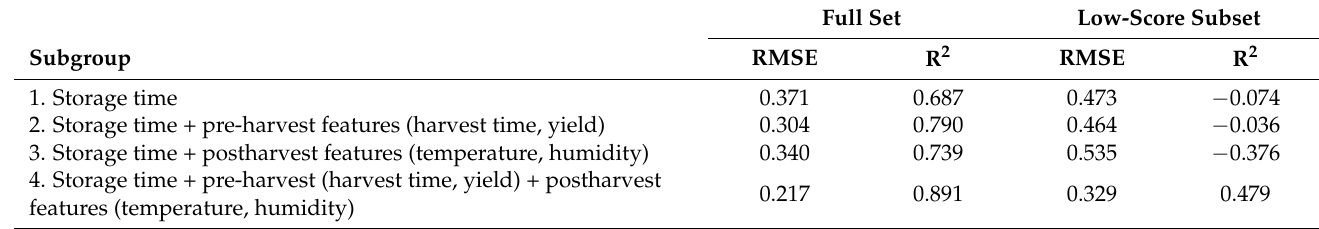
Table 5. The RMSE and R 2 values for the XGBoost regression model with five duplications for the full data set and low-score subset, using four different feature subgroups. Full Set Low-Score Subset RMSE R 2 RMSE R